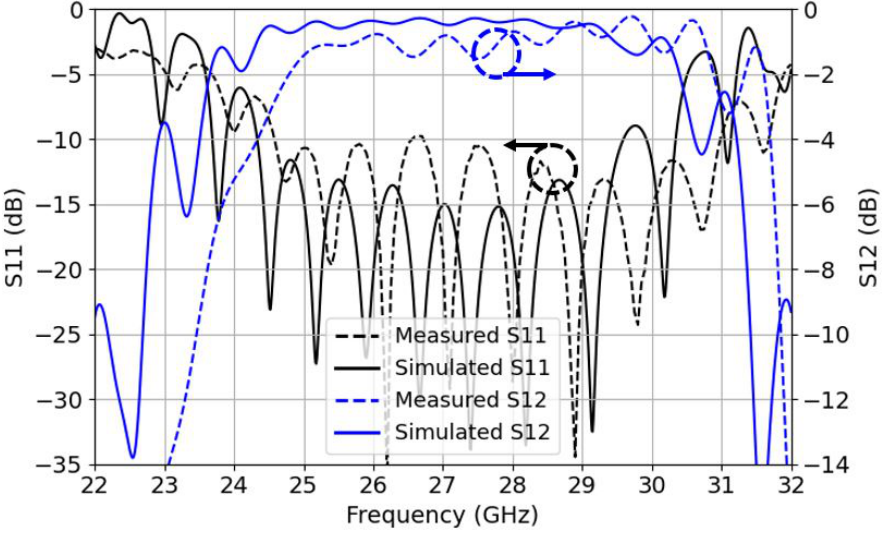
Figure 11. Bottom-side back-to-back S11 reflection coefficients (left y-axis) in black and insertion losses S12 (right y-axis) in blue for the measurements and